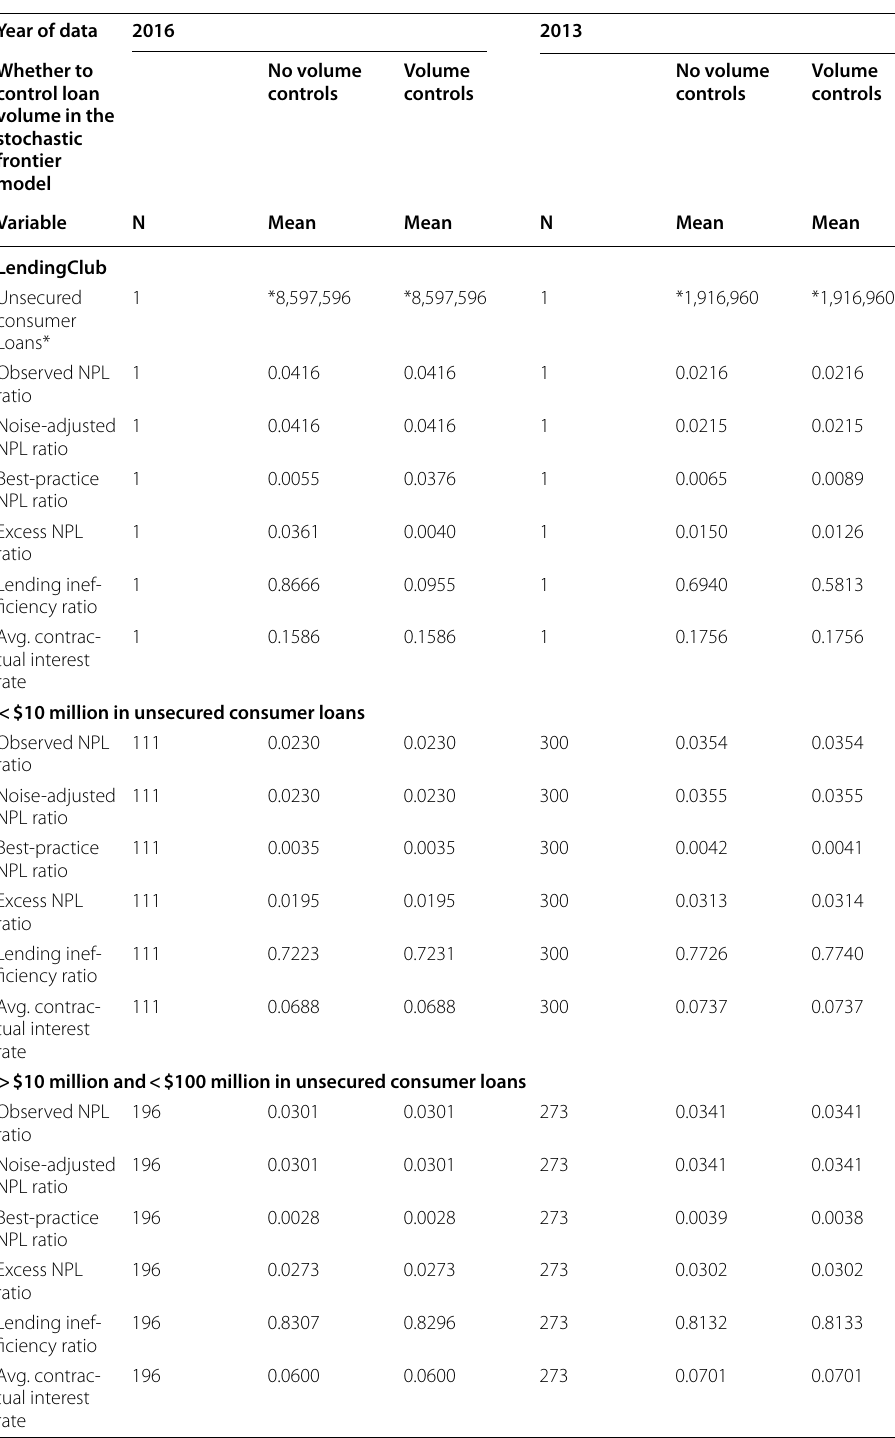
Table 9 NPL ratio and its decomposed components by size groups of unsecured consumer loans: 2016 and